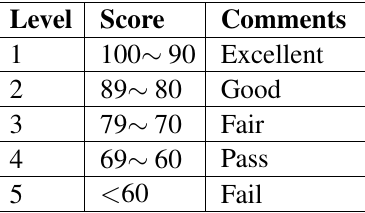
Table 3 Score values of each